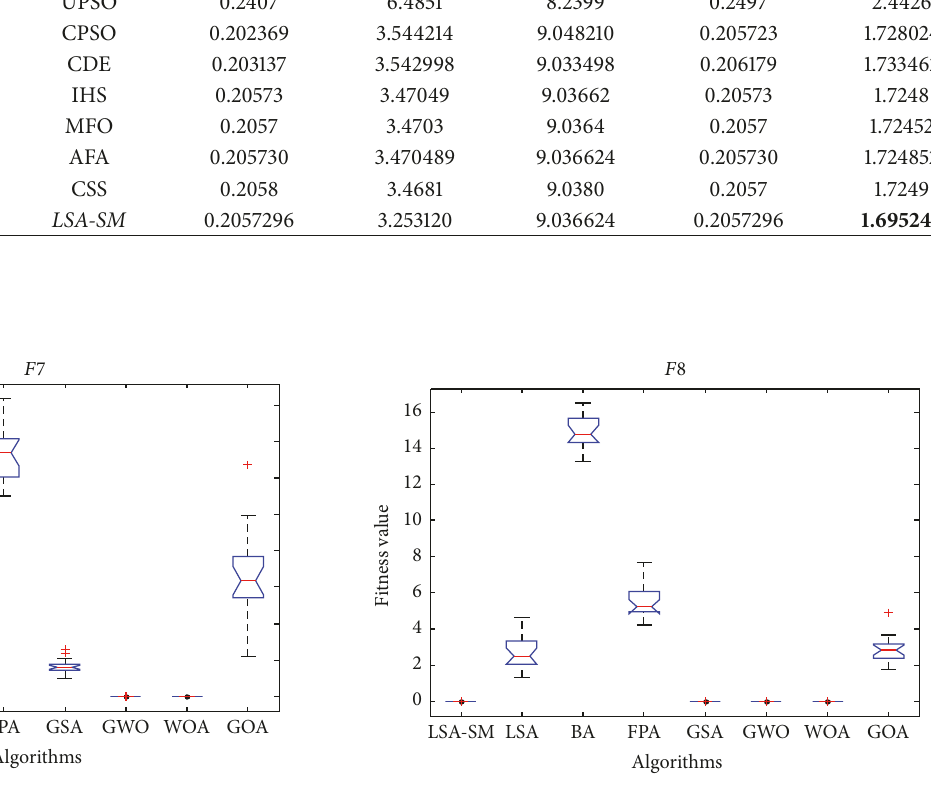
Figure 29: 𝐷 = 30 , ANOVA test of global minimum for 𝑓 07 . Figure 30: 𝐷 = 30 , ANOVA test of global minimum for 𝑓